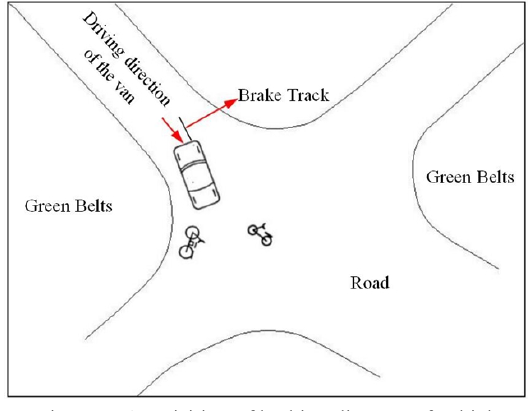
Figure 7. Acquisition of braking distance of vehicle